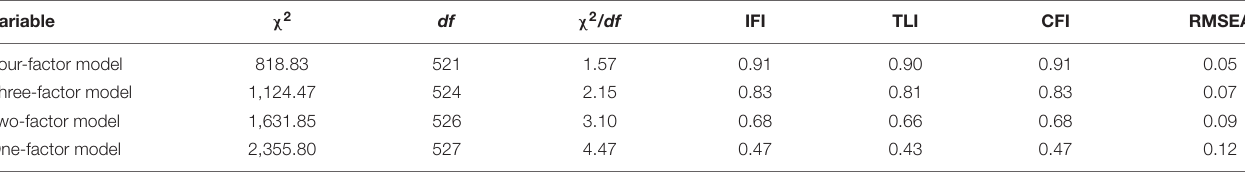
TABLE 1 | Results of confirmatory factor analysis.